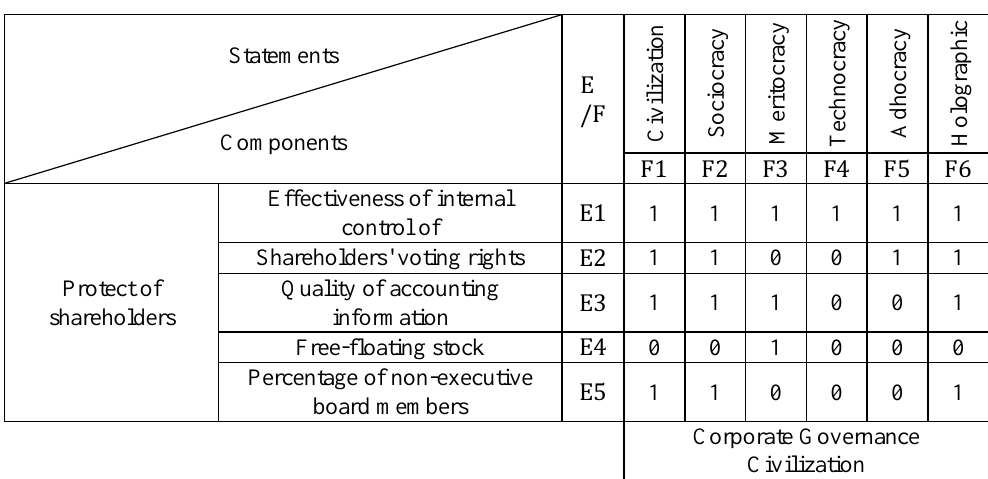
Table 8. Matrix Interaction of the consequences of Investor Protection with Corporate Governance Civilization